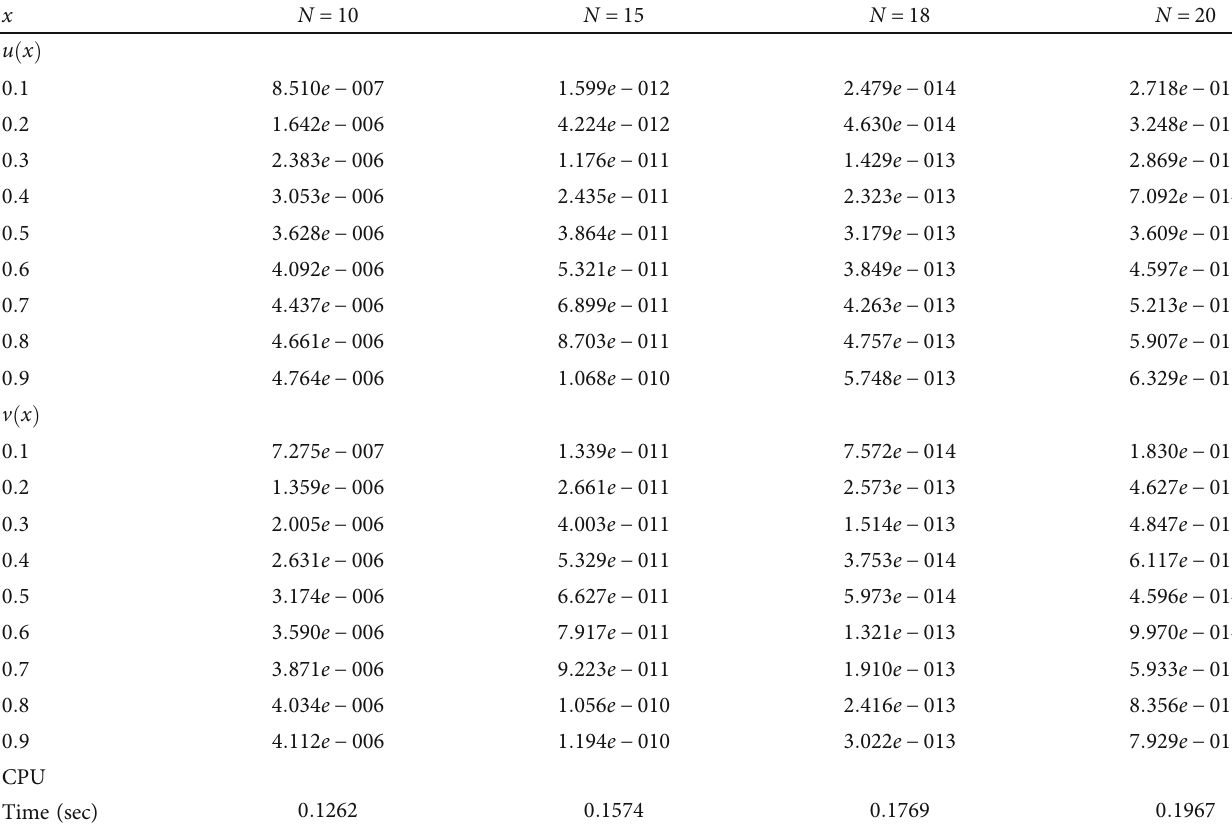
Table 6: Maximum absolute errors of u ð x Þ and v ð x Þ for Example 4 at various values of x and N . x N =